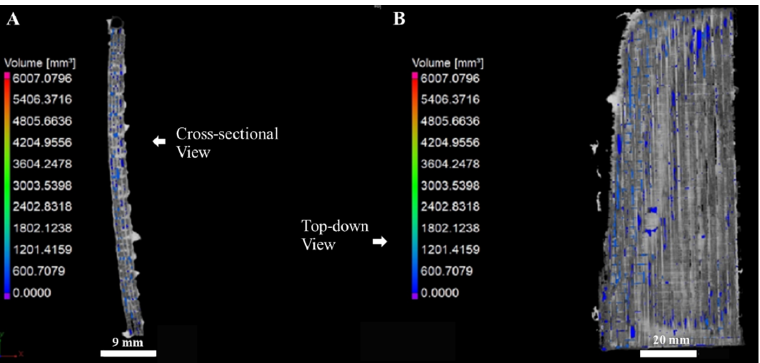
Figure 7. XCT scans of ( A ) cross ‐ section and ( B ) top ‐ down views showing the total porosity in the C/C ‐ SiC composite.